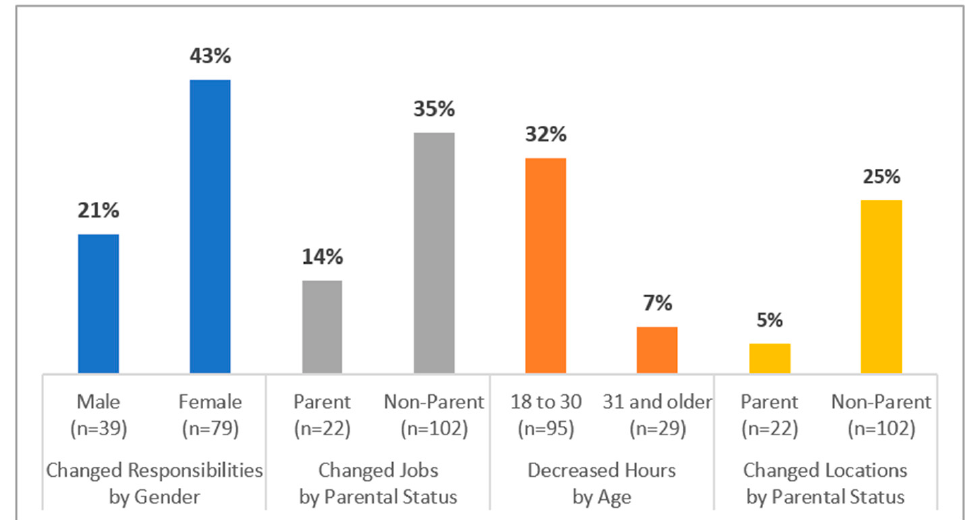
Figure 6. COVID-19 impact on current employment by demographic attribute.